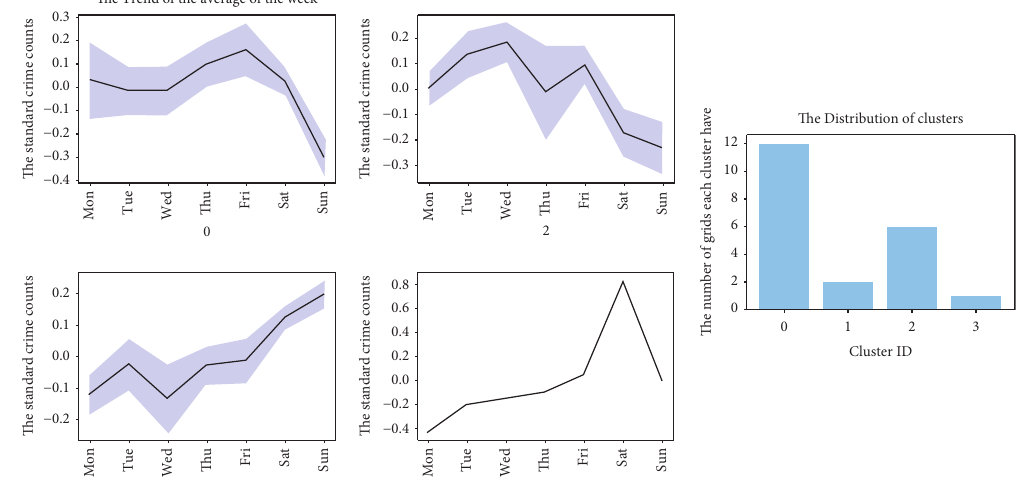
Figure 4: Chicago 2018 theft weekly trends and distribution of the clusters. The line charts are the monthly trends of theft in Chicago in 2018. The bar chart is the distribution of the